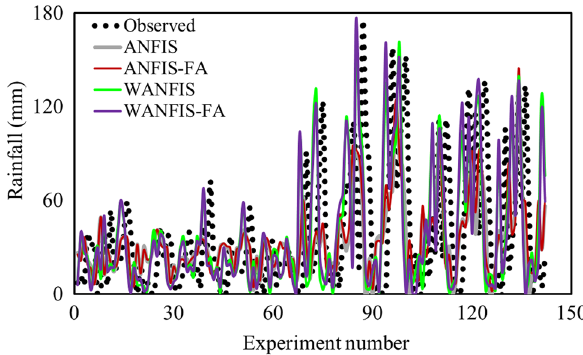
Fig. 14 Comparison of WANFIS-FA model capability in simulating Ardabil rainfall values with ANFIS, ANFIS-FA, and WANFIS mod-